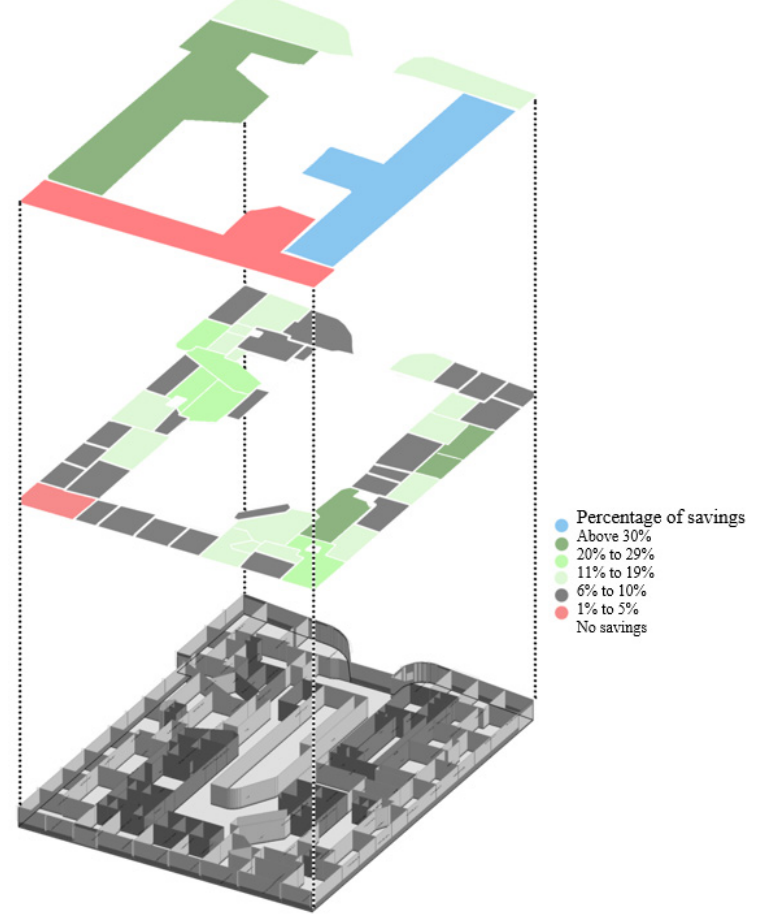
Figure 4. Floorplan with the indication of the cooling load reduction by thermal zone. Bottom: fine-grained thermal zoning. Mid: potential savings introduced by the real-time occupancy scenario compared to the NABERS reference scenario. Top: potential savings introduced by the simplified scenario compared to the NABERS reference scenario.